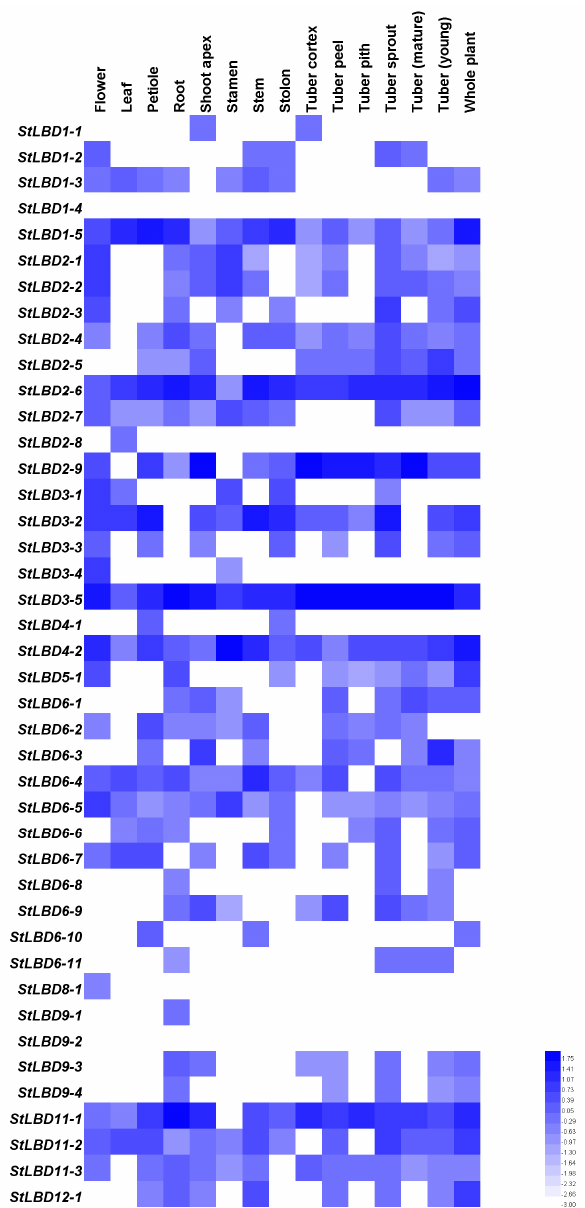
Figure 5. The expression profiles of StLBD genes in different tissues of potato. Transcripts were detected by RNA-Seq technology. The heatmap showed StLBD gene expression across 15 tissues covering the entire potato life cycle, including the flower, leaf, petiole, and root, shoot apex stamen stem stolon, tuber cortex, tuber peel, tuber pith, tuber sprout, mature tuber, young tuber, and whole plant. In this figure, blue and white are used to indicate the expression level of each tissue gene. Blue indicates gene up-regulation, while white indicates gene down-regulation.